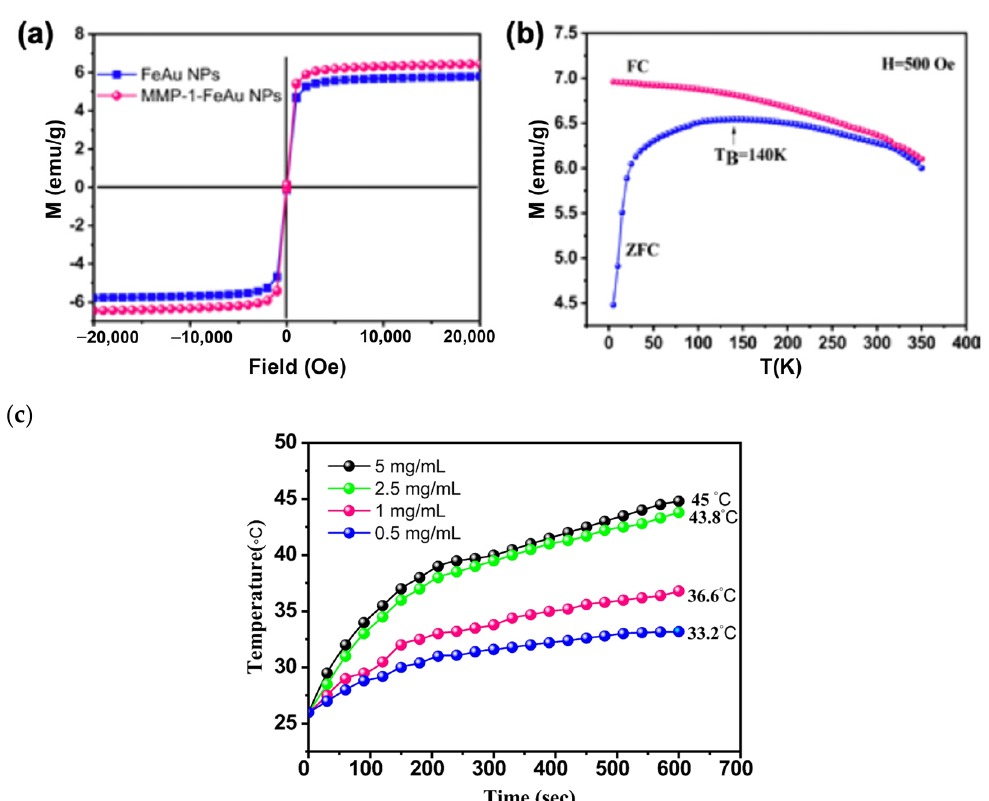
Figure 4. Magnetic properties of FeAu NPs as analyzed using SQUID. ( a ) ZFC/FC curve of FeAu NPs and MMP1-FeAu NPs (M-T curve), ( b ) hysteresis curves of FeAu NPs and MMP1-FeAu NPs (M–H curve) and ( c ) temperature elevation of the solution with the addition of different concentrations of FeAu NPs and stimulation with AMF over 10 min.